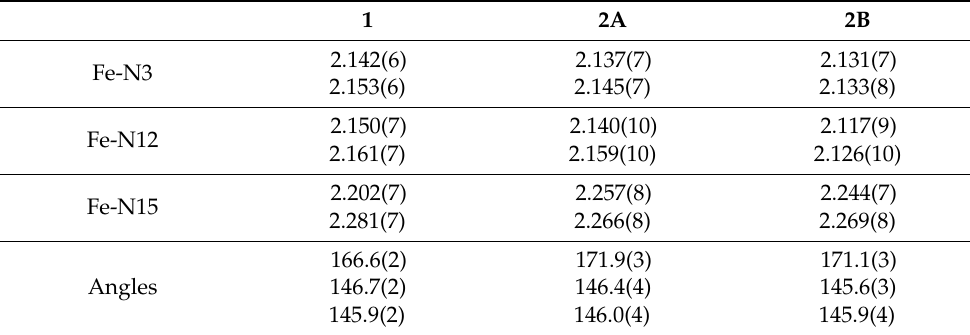
Figure 2. Perspective views of the cation observed in the structure 1 ( A ) and one of the symmetry-independent cationic complexes of 2 ( B ). Ellipsoids are drawn at the 50% probability level, hydrogen atoms are shown as spheres of arbitrary radii. Table 2. Relevant geometrical parameters (Å, °) with s.u.’s in parentheses.